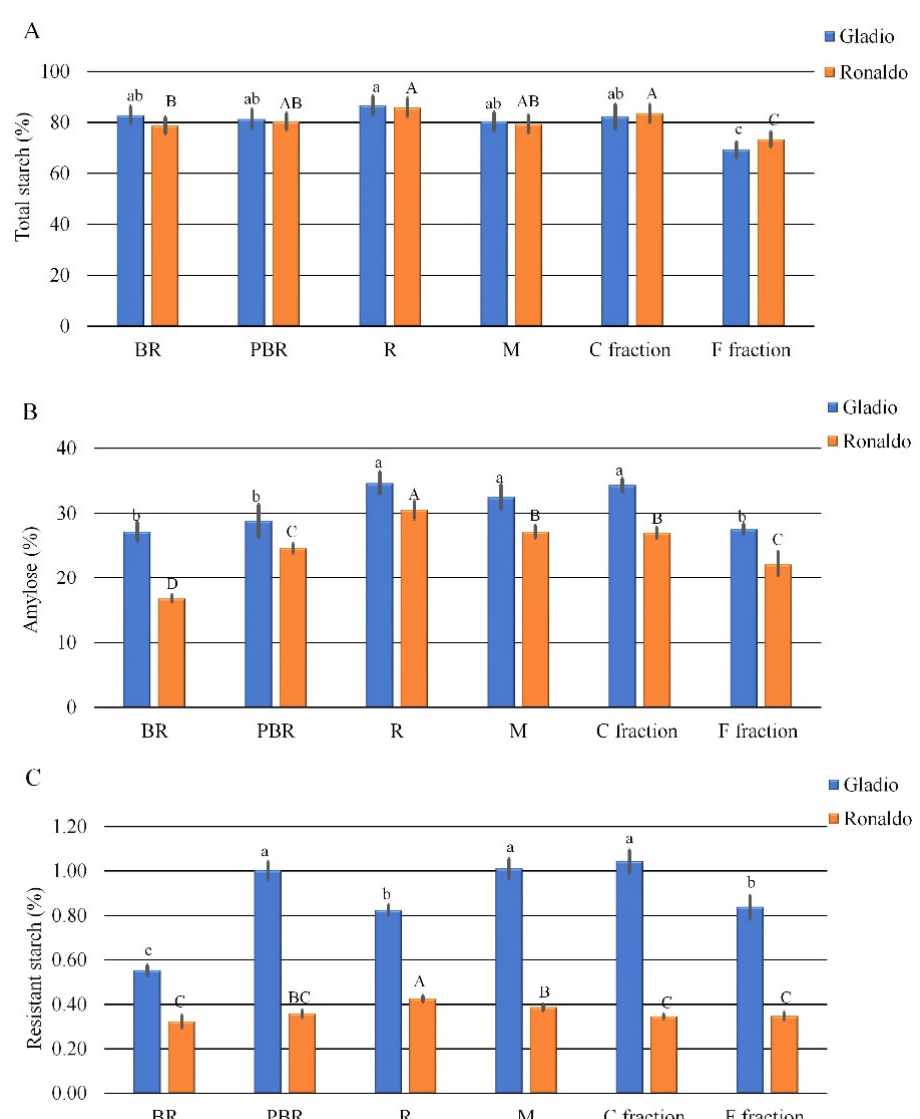
Figure 2. Total starch ( A ), amylose ( B ) and resistant starch ( C ) content in raw materials of rice cultivars Gladio and Ronaldo. BR = Brown Rice; PBR = Parboiled Brown Rice; R = Refined parboiled flour; M = Micronized parboiled flour; C = Coarse; F = Fine. Different letters indicate significant differences determined by the Mann–Whitney pairwise test ( p ≤ 0.05). Lower case letters refer to cv Gladio; upper case letters refer to cv Ronaldo. Results are expressed as ± standard deviation for three replications.